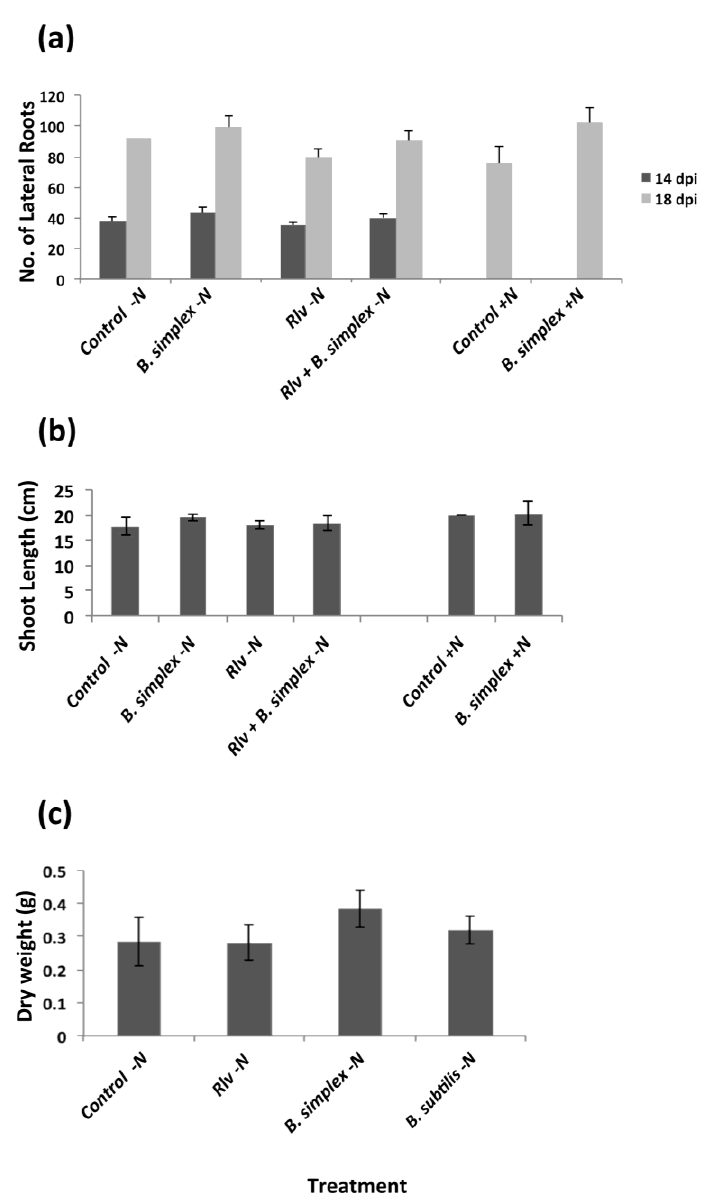
Figure 3. Growth measurements of uninoculated and inoculated pea plants grown in Magenta jars ( a , b ) or pots ( c ); (a) Average number of lateral roots 14 dpi and 18 dpi from either four or six different treatments including the uninoculated control (without or with N); B. simplex (without or with N) or Rlv alone (without N) and the two bacteria mixed together in a 1:1 ratio (without N); (b) Same treatment as above, but shoot length measurements were made 18 dpi; (c) Effect of Bacillus strains on pea root biomass. Peas inoculated with B. simplex , B. subtilis , or R. leguminosarum bv. viciae , or left uninoculated were grown in pots in a UCLA Plant Growth Center greenhouse (22.3 °C) under N-deficient conditions (−N). At 18 dpi, roots were isolated and dried at 55 °C for 48 h. For a – c , the number of plants measured per treatment was 8–10. All experiments were repeated at least 3 times. Significance between means was tested, after a variance analysis was performed, using Duncan’s Multiple Range test at p < 0.05. Standard errors are